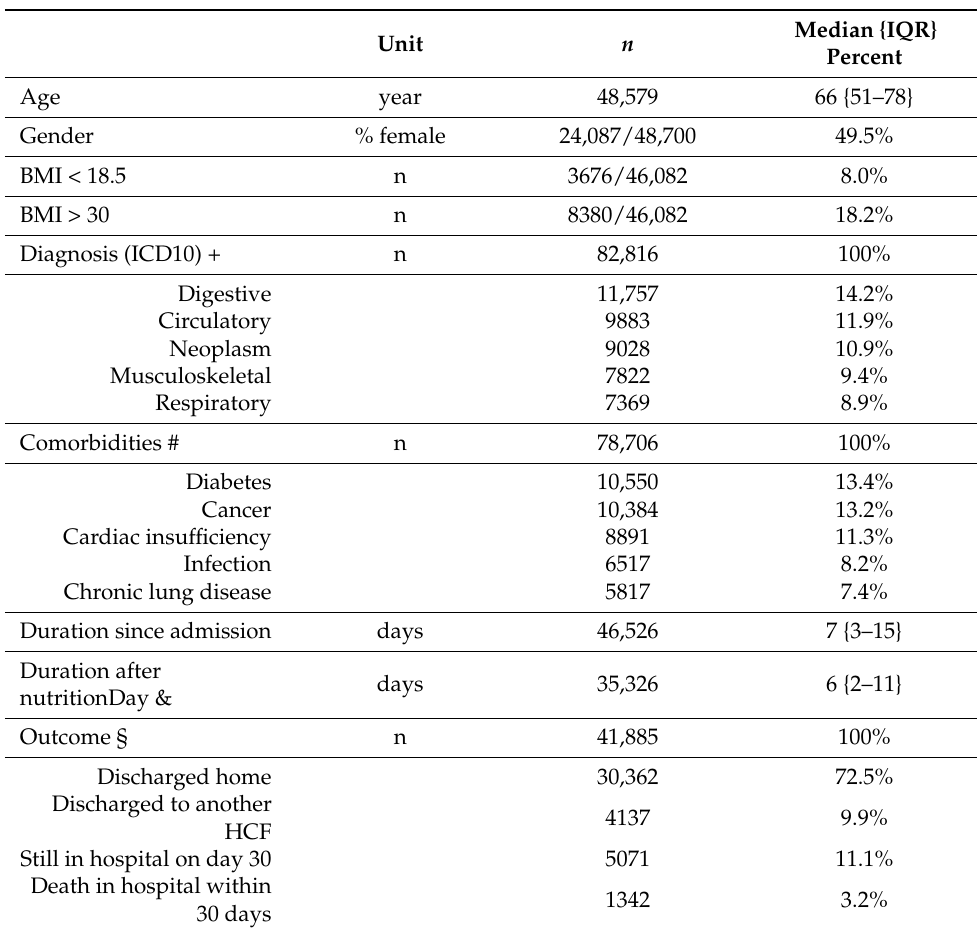
Table 2. Patient characteristics ( n =